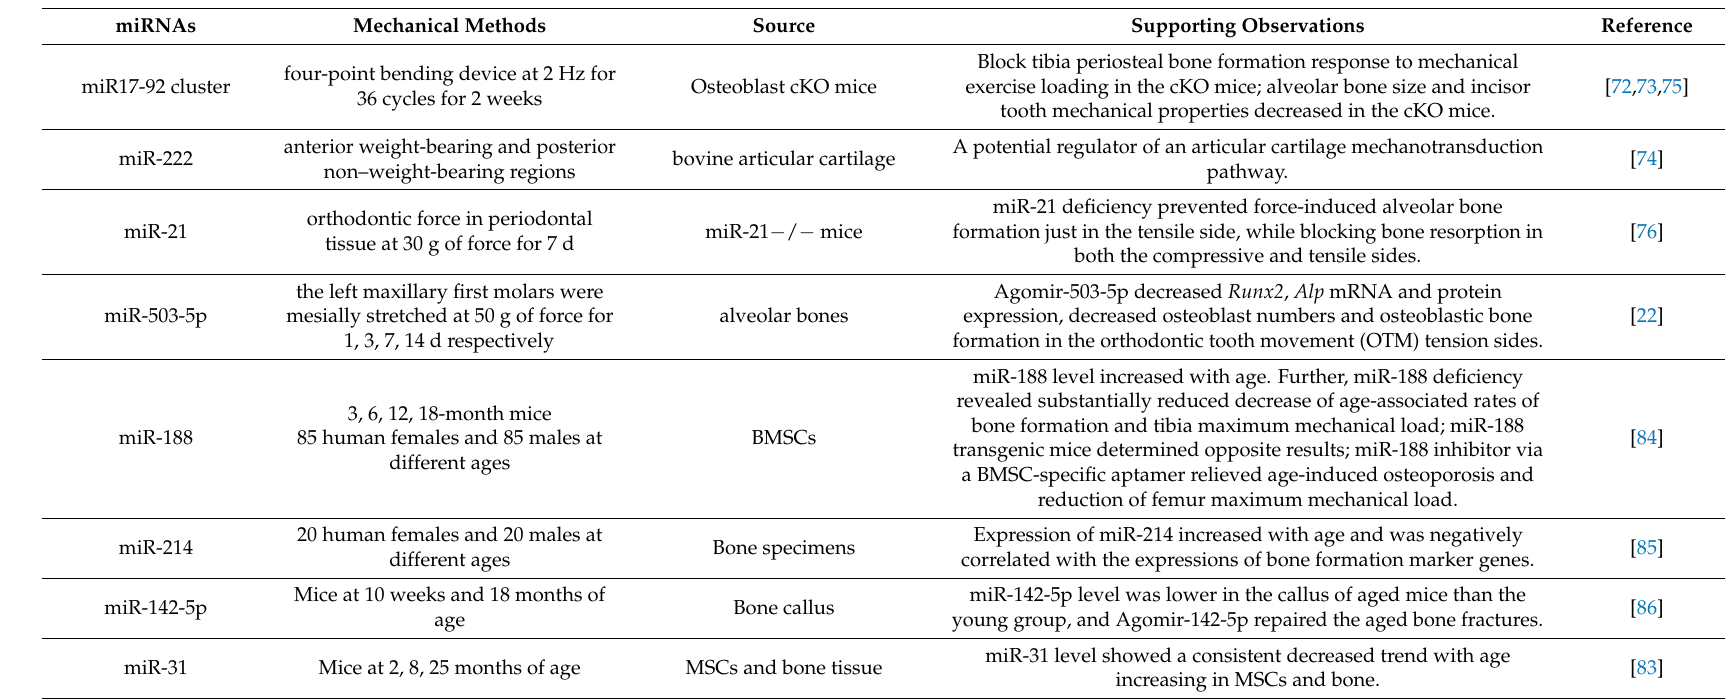
Table 5. The roles of mechanosensitive miRNAs in bone